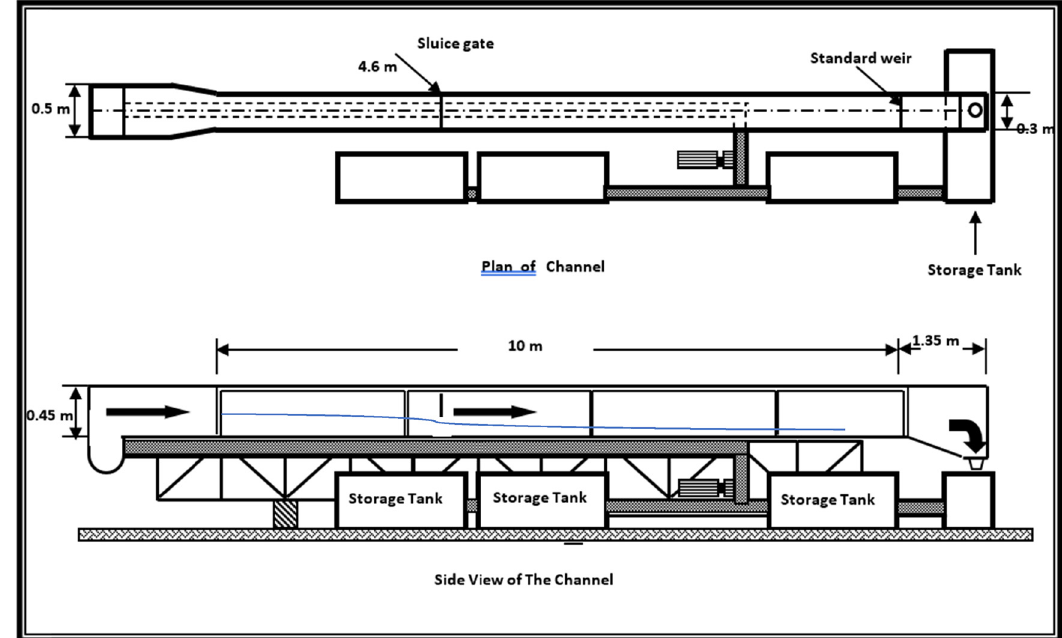
Figure 1: The laboratory